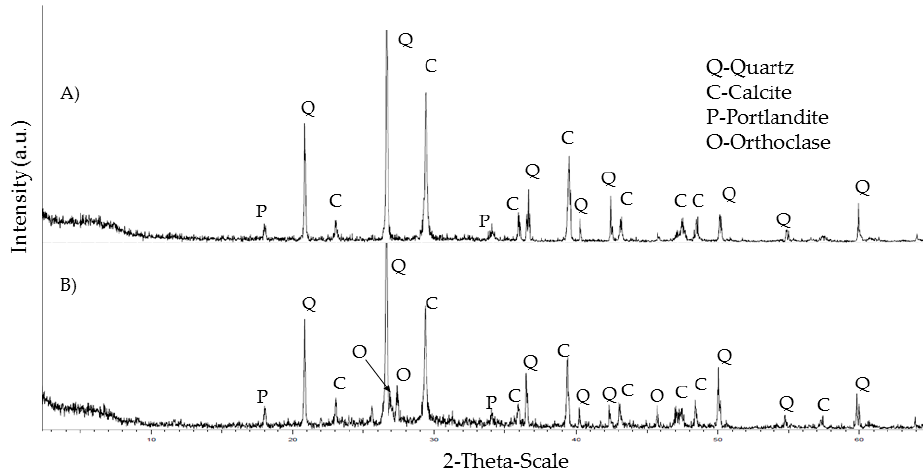
Figure 7. Mineral analysis of mortar specimens REF ‐ I ( A ) and M ‐ VI ( B ).